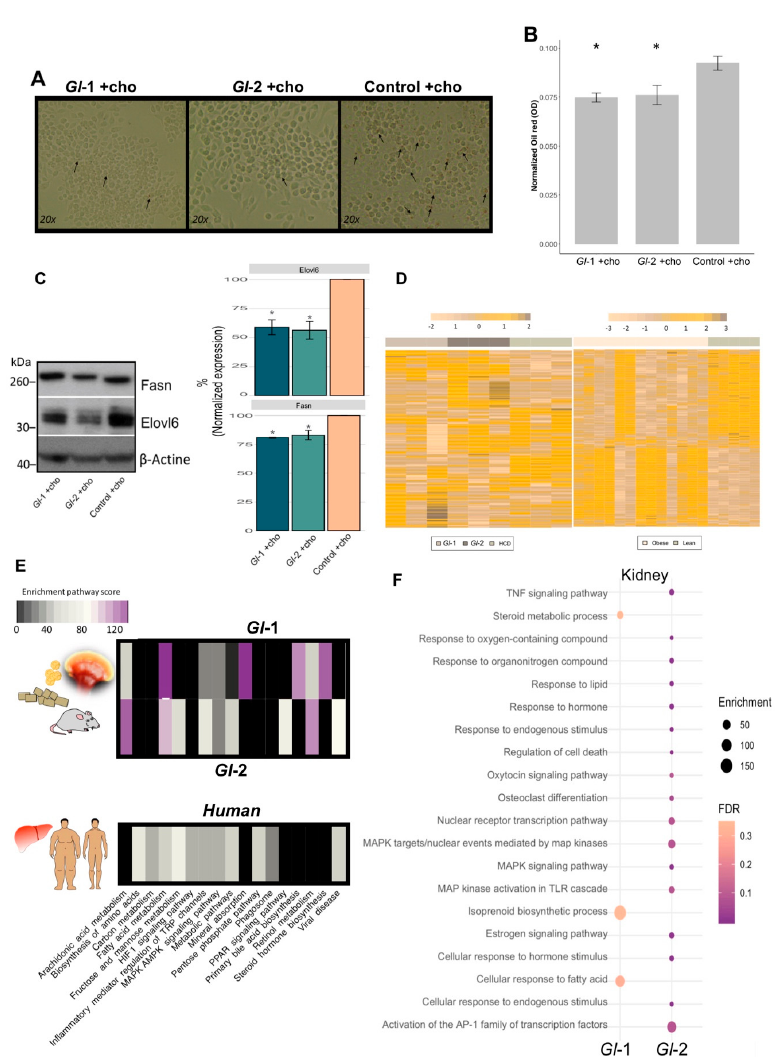
Figure 5. Ganoderma lucidum extracts ( Gl -1, Gl -2) modulate the transcriptional landscape of hepatic-like macrophages and kidney tissue, as well as the common mouse-human metabolic process. ( A ) Oil red O staining of RAW 264.7 macrophages grown in high cholesterol conditions, after the intervention with Gl - 1 and Gl - 2 extracts, in comparison with the untreated control (vehicle). Zoom images obtained at 20x. Arrows indicate lipid accumulation. ( B ) Absorbance quantification of oil red O staining normalized by sulforhodamine B (SRB) absorbance levels of each experimental condition. Contrast: Absorbance of Gl - 1 or Gl - 2 extracts vs Control, * p < 0.05. ( C ) Western blot for Fasn and Elovl6 in RAW 264.7 macrophage-like cell line treated with Gl extracts ( Gl -1, Gl -2), as well as the untreated control (vehicle), under high cholesterol concentrations. Representative blot from two independent experiments. Bar plot described the results of two independent experiments with three technical replicates represented as the mean+/ − standard deviation error. * p < 0.05 ( D ) Comparative transcriptional landscape of homologous human and mouse genes modulated by both Gl -1 and Gl -2 extracts in liver tissue of C57BL/6 mice, under a high-cholesterol diet (HCD), in comparison with differentially expressed genes in liver tissue of obese versus lean patients. ( E ) Enriched pathways shared between hepatic genes modulated by Gl extracts ( Gl -1, Gl -2) in mice, and altered hepatic genes in obese versus lean patients. ( F ) Bubble plot showing the pathway enrichment analysis of differentially expressed renal genes of C57BL/6 mice fed with a HCD, and treated with Gl -1 and Gl -2 extracts. The bubble size represents the enrichment score, while the bubble color indicates FDR values. Ch: